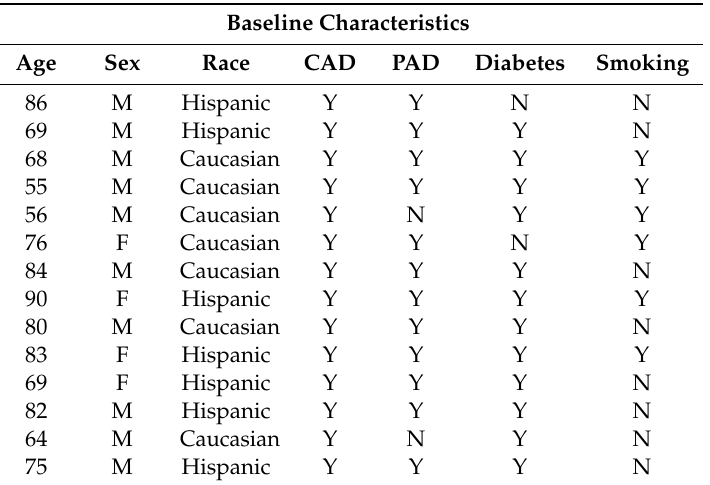
Table 2. Baseline characteristics: Patients ( n = 14) age, sex (male (M) or female (F)), and race. Additionally, a history of coronary artery disease (CAD), peripheral artery disease (PAD), diabetes, and smoking is indicated with a yes (Y) or no (N).